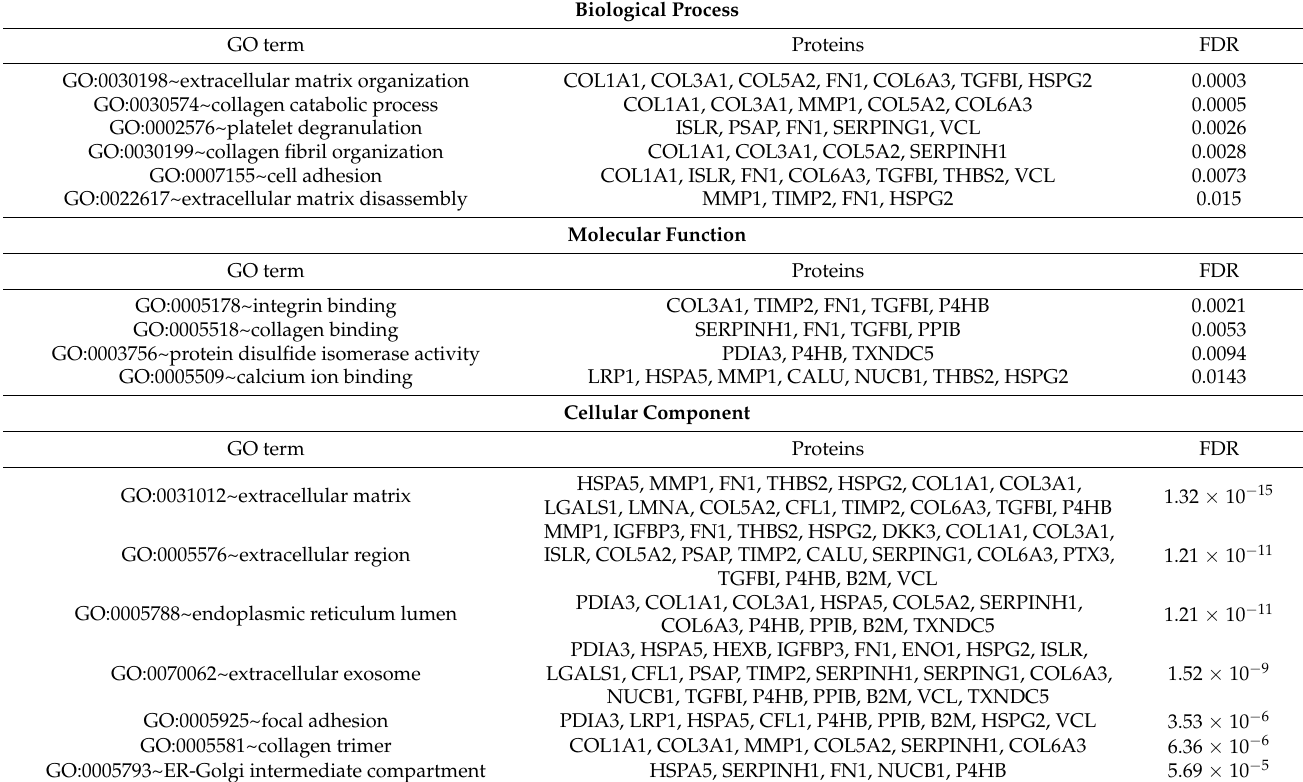
Table 2. The most enriched GO categories related to DEPs identified in the hEDS